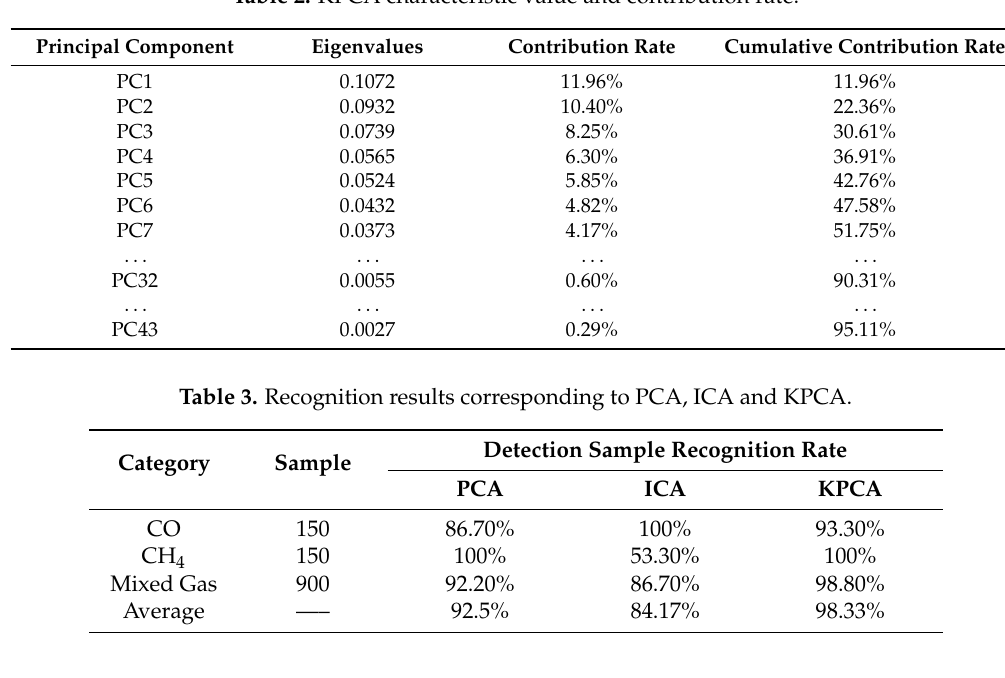
Table 2. KPCA characteristic value and contribution rate.